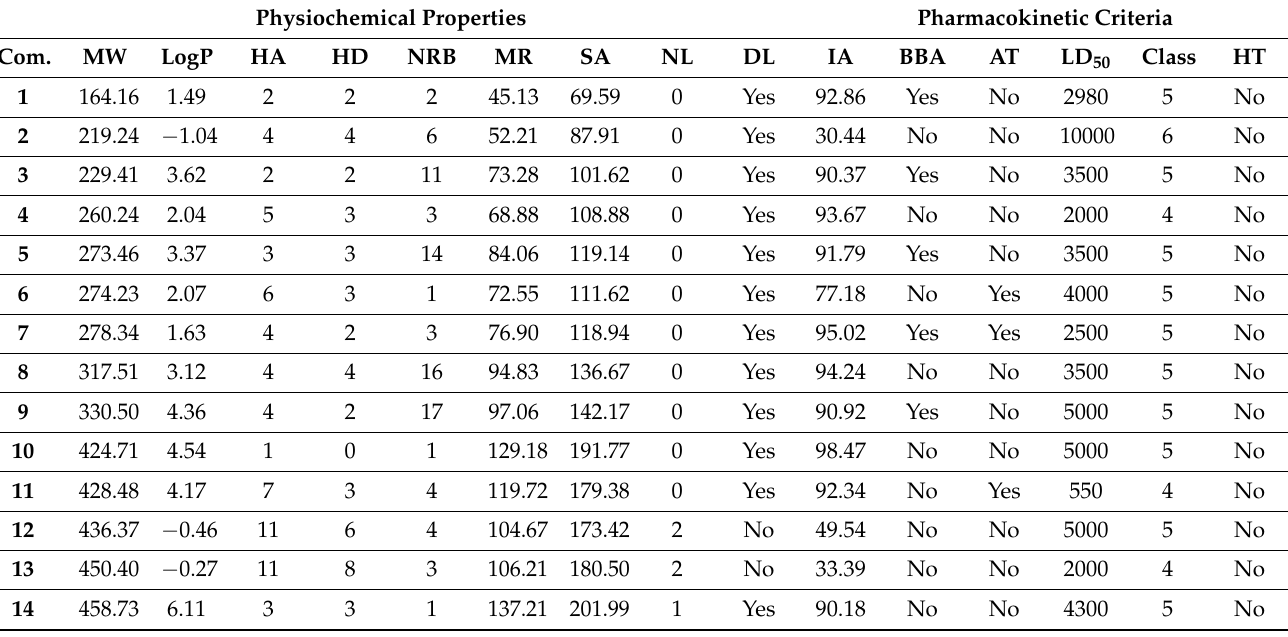
Table 4. Physiochemical and pharmacokinetics profile of all the identified